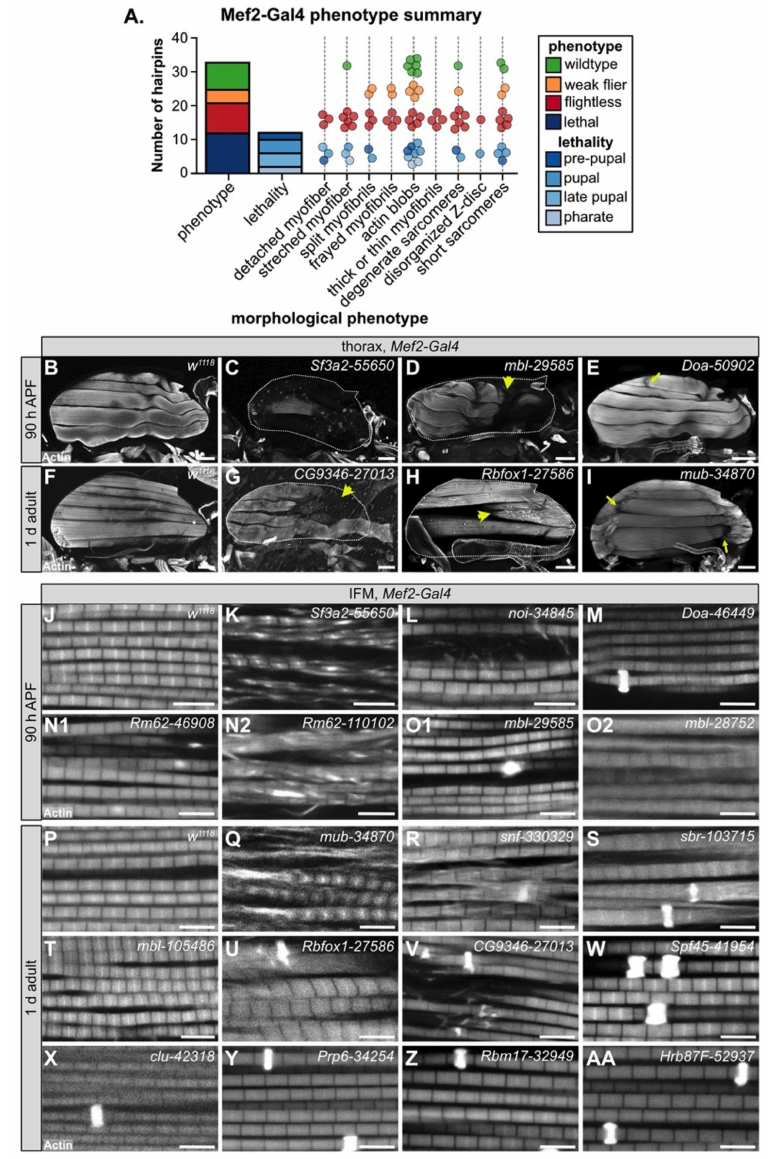
Figure 3. Mef2-Gal4 knockdown of RBPs produces diverse myofibril and sarcomere phenotypes. ( A ) Graphical summary of confocal phenotypes from 35 hairpins targeting 17 RBP genes. Dots represent hairpins and are colored by flight (flightless, red; weak flier, orange) and lethality (blue shades) phenotype. Hairpins may appear in more than one morphological phenotype category. ( B – I ) Confocal Z-projections of IFM hemi-thoraxes showing myofiber phenotypes at 90 h APF ( B – E ) or in 1 d adult ( F – I ). Torn, detached or missing fibers are observed in severe examples (yellow arrow heads in D , E , G , H ) and classified as “detached myofiber” in ( A ). Other myofibers are stretched (yellow arrows in ( E , I) ), likely reflecting hypercontraction. White dotted lines mark boundary of the thorax in ( C , D , G ) and ( H ). Scale bars = 100 µ m. ( J – AA ) Confocal single-plane images showing myofibril and sarcomere structure at 90 h APF ( J – O2 ) or in 1 d adult ( P – AA ). As compared to w